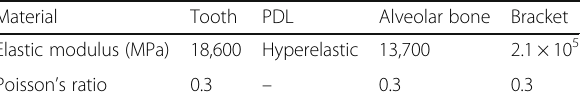
Table 2 Mechanical property of four materials Material Tooth PDL Alveolar bone Bracket Elastic modulus (MPa) 18,600 Hyperelastic 13,700